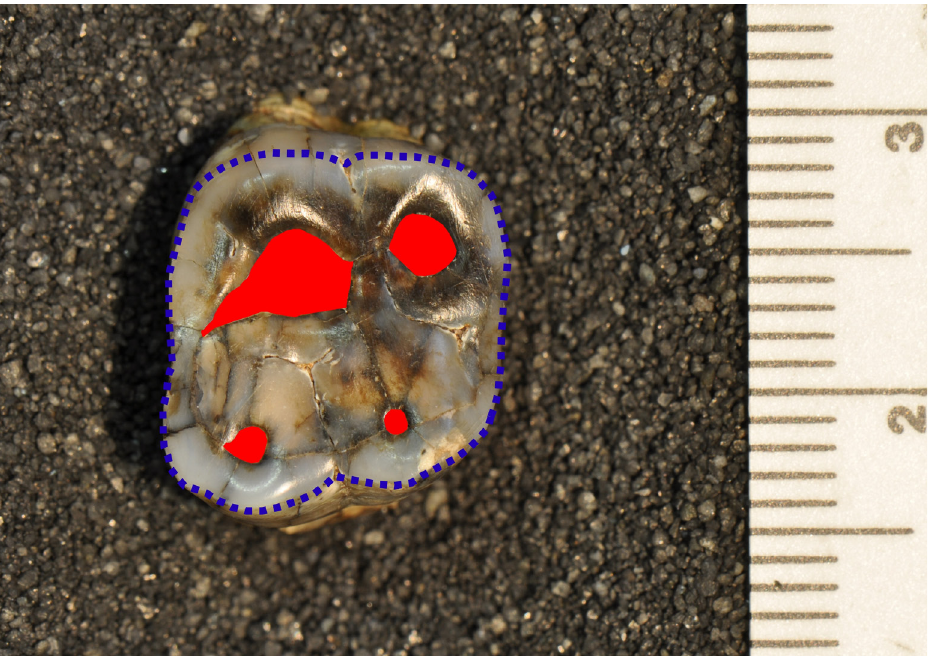
Fig. 4: An image of the occlusal (biting) surface of a molar with the occlusal outline high- lighted in blue and the area of dentine highlighted in